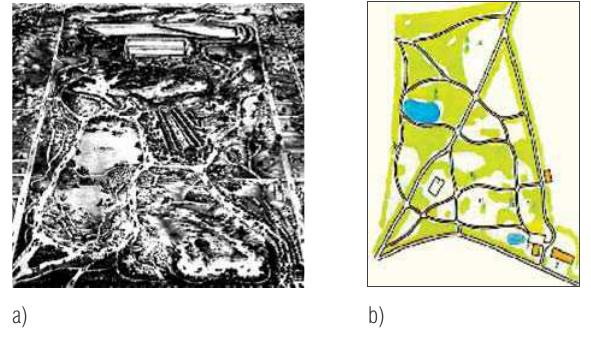
Fig 1. Examples of the 19th century parks a) Central Park in New York, b) Plateliai Park in